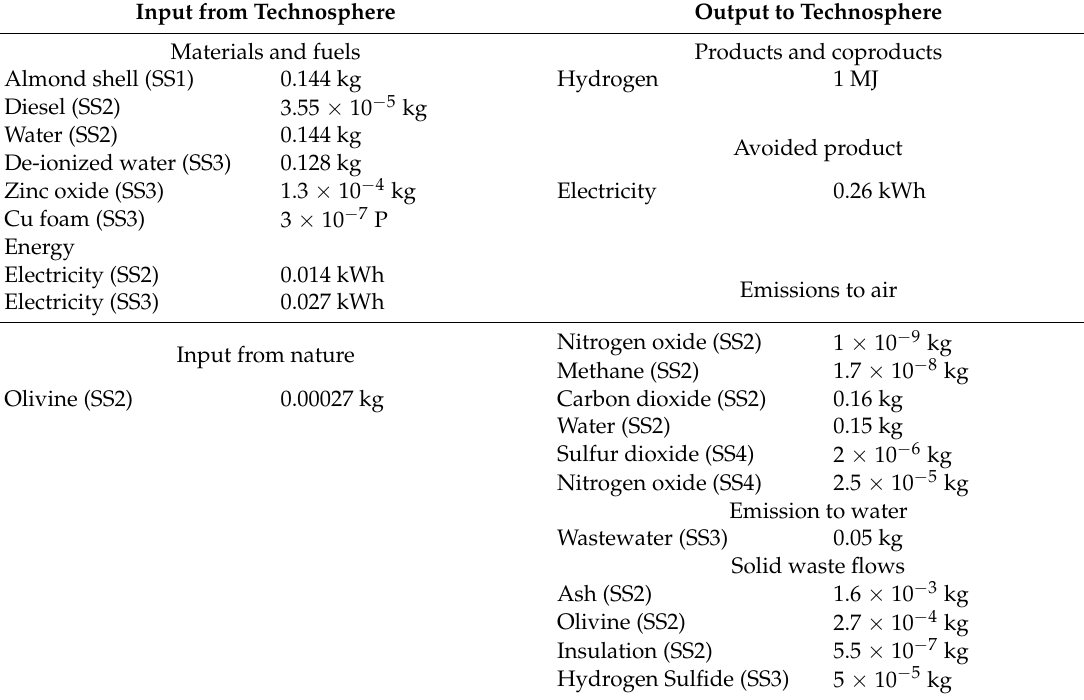
Table 6. Main inventory data for hydrogen production via almond shell gasification per